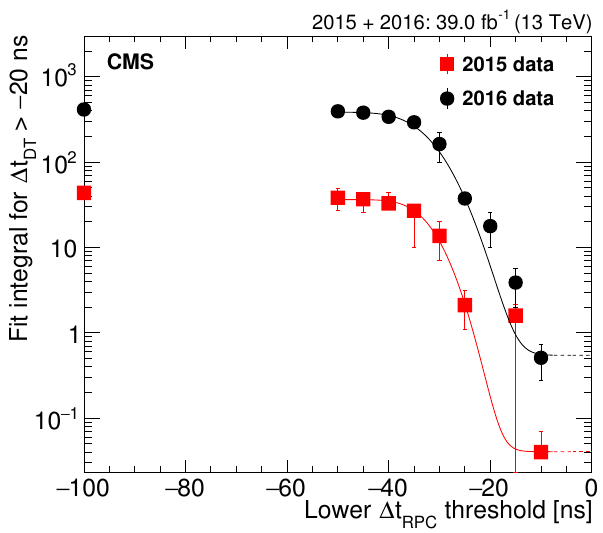
Figure 3 . The background extrapolation for the muon search. The integral of the (cid:12)t function to (cid:1) t DT with the sum of two Gaussian distributions and a Crystal Ball function, for (cid:1) t DT > (cid:0) 20 ns, is plotted as a function of the lower (cid:1) t RPC selection, for 2015 (red squares) and 2016 (black circles) data. The points are (cid:12)tted with an error function and used to extrapolate to the signal region, which is de(cid:12)ned as (cid:1) t RPC > (cid:0) 7 : 5